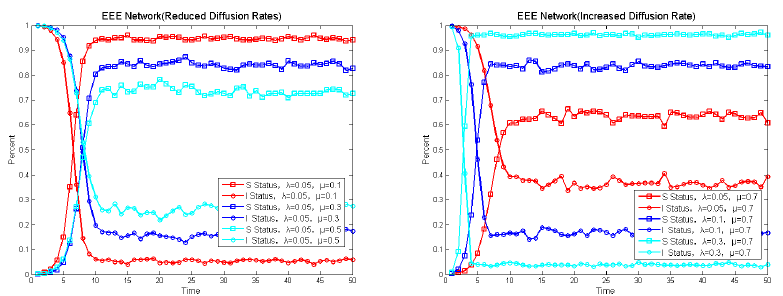
Figure 10. Influence of diffusion rate on spread in three-layer EEE network.